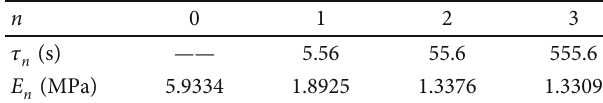
Table 2: The relaxation modulus prony series coe ffi